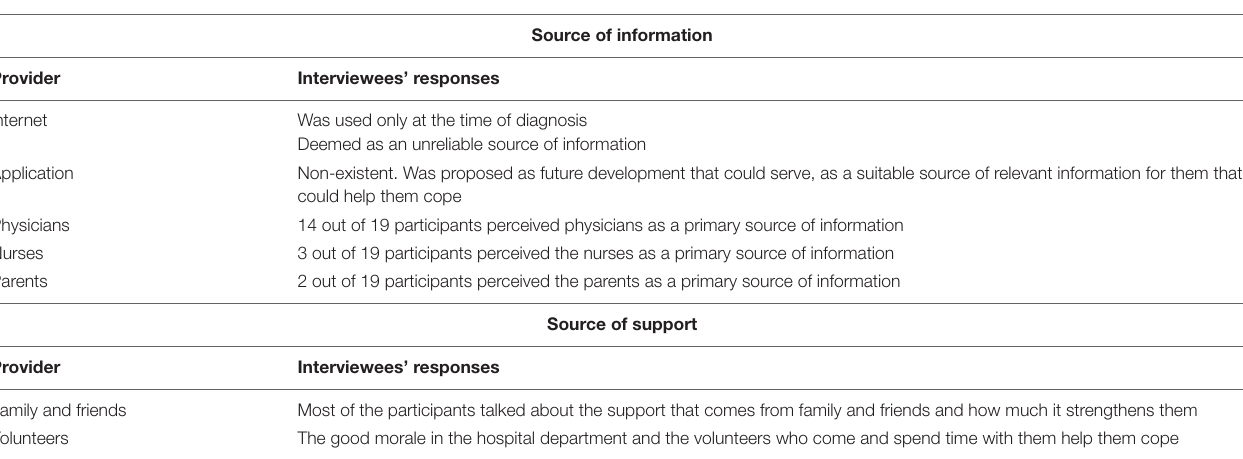
FIGURE 1 | A summary of information known, the additional information they would like to receive, the information that some of them would rather not known and their request. TABLE 3 | The sources of information and support for children and